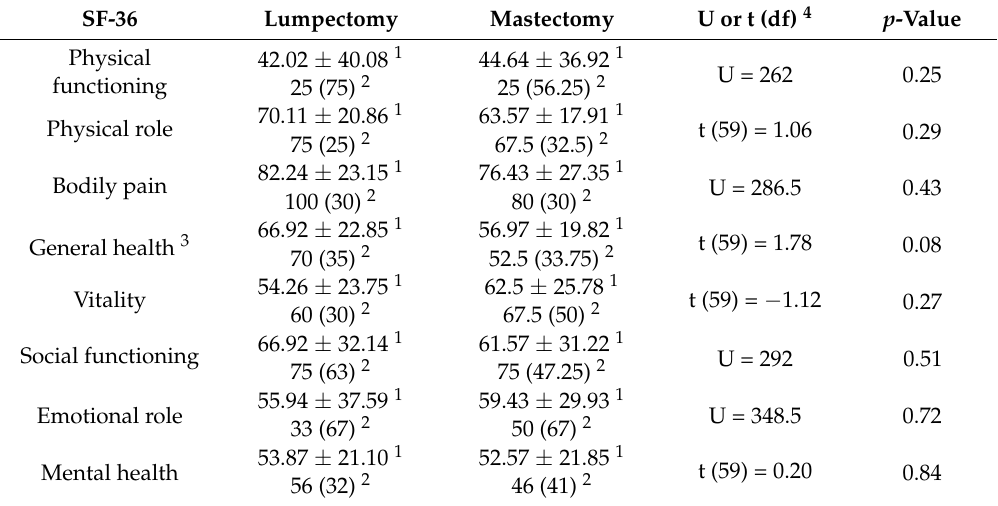
Table 9. Effects of surgery type on SF-36 subscales.